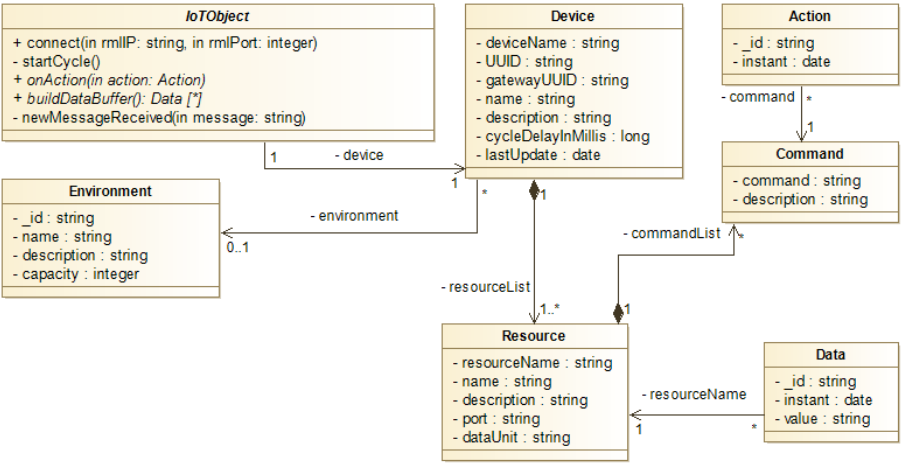
Figure 3. The extended RMA